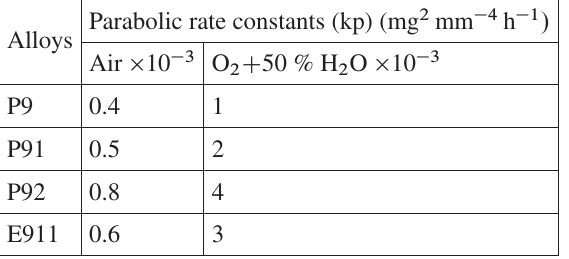
Table 7. Parabolic rate constants (mg 2 mm (cid:3) 4 h (cid:3) 1 / at 1073 K.